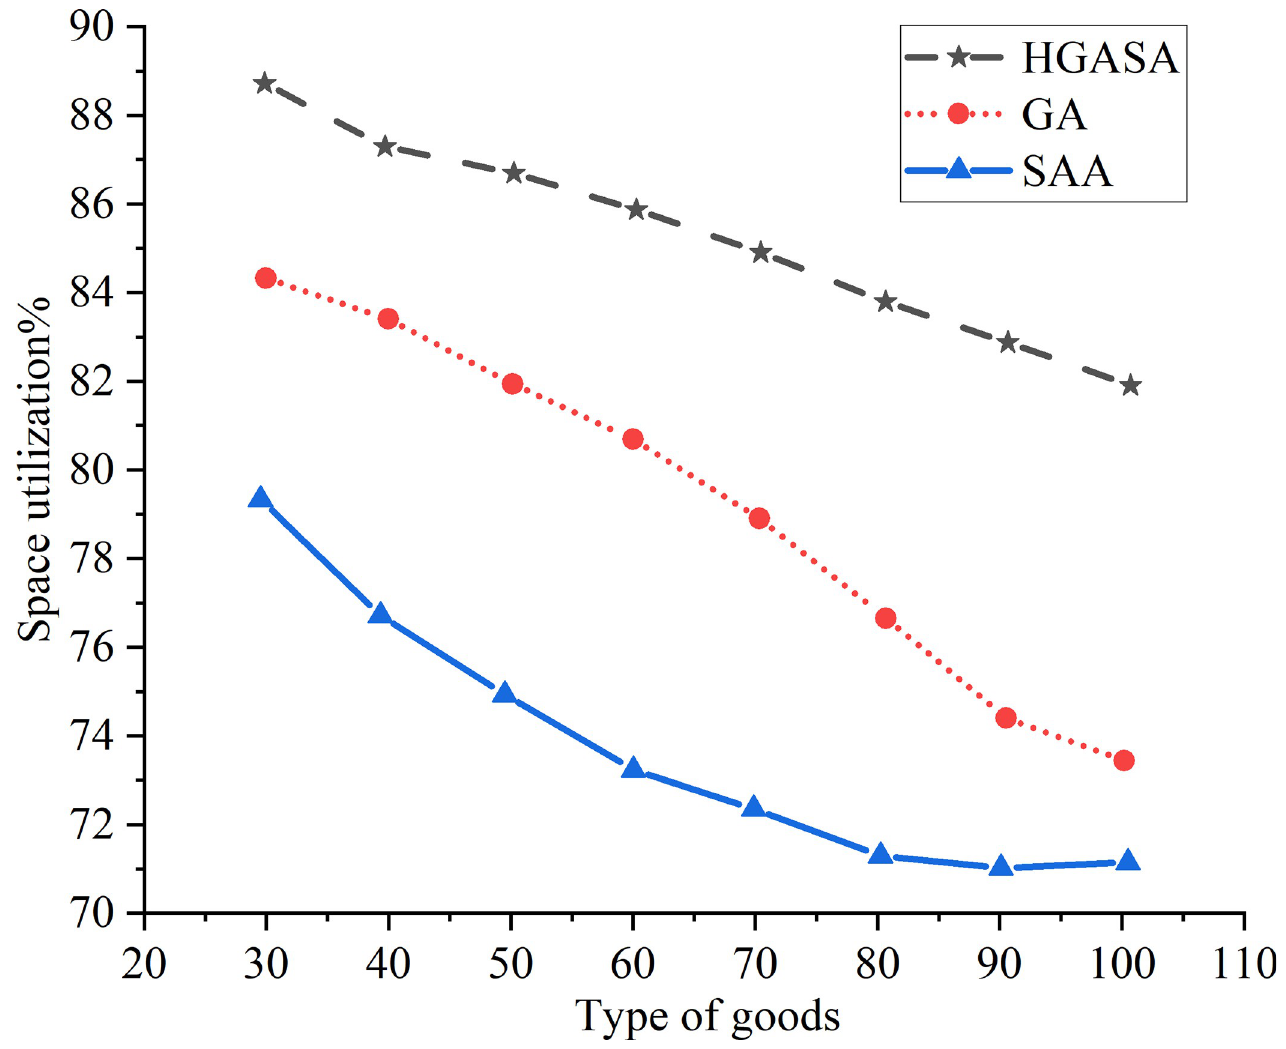
Fig 17. Comparison of space utilization of three